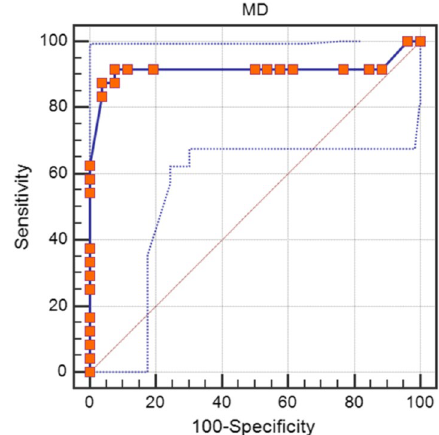
Fig. 2 ROC curve for evaluation of MD values in detection of malignant